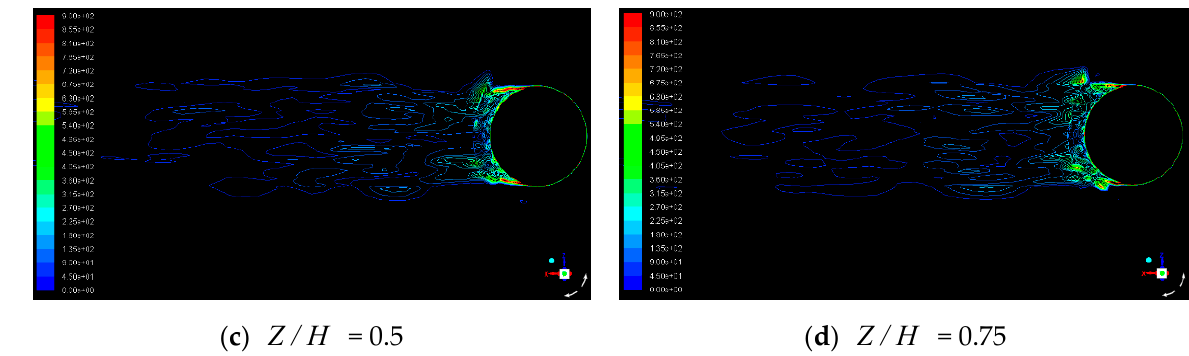
Figure 13. Contour lines of vorticity in the horizontal plane at H / D = 0.3: ( a ) Z / H = 0; ( b ) Z / H = 0.25; ( c ) Z / H = 0.5 and ( d ) Z / H = 0.75.